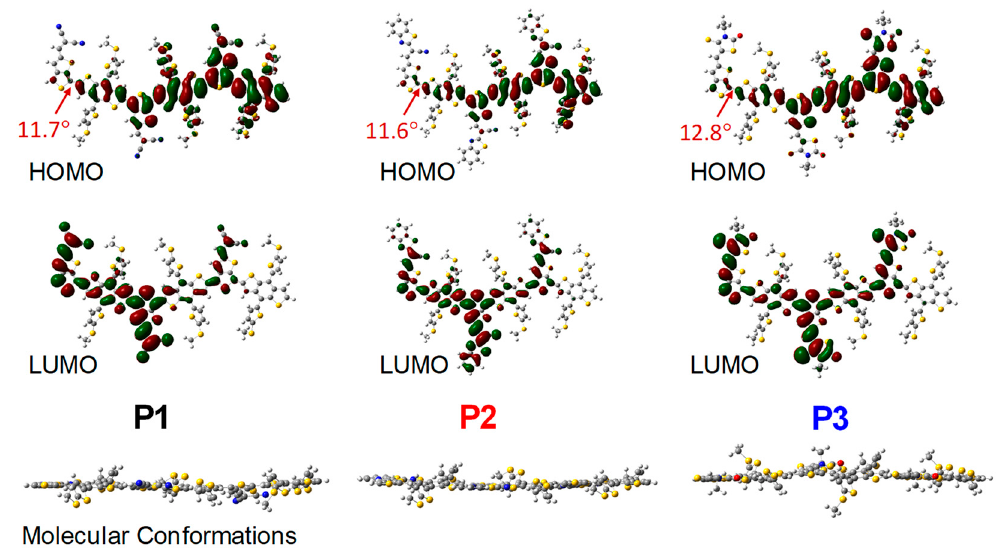
Figure 4. The electron density distribution of the copolymers using density function theory calculations based on the analogous trimer model and the side view molecular conformations of the copolymers.